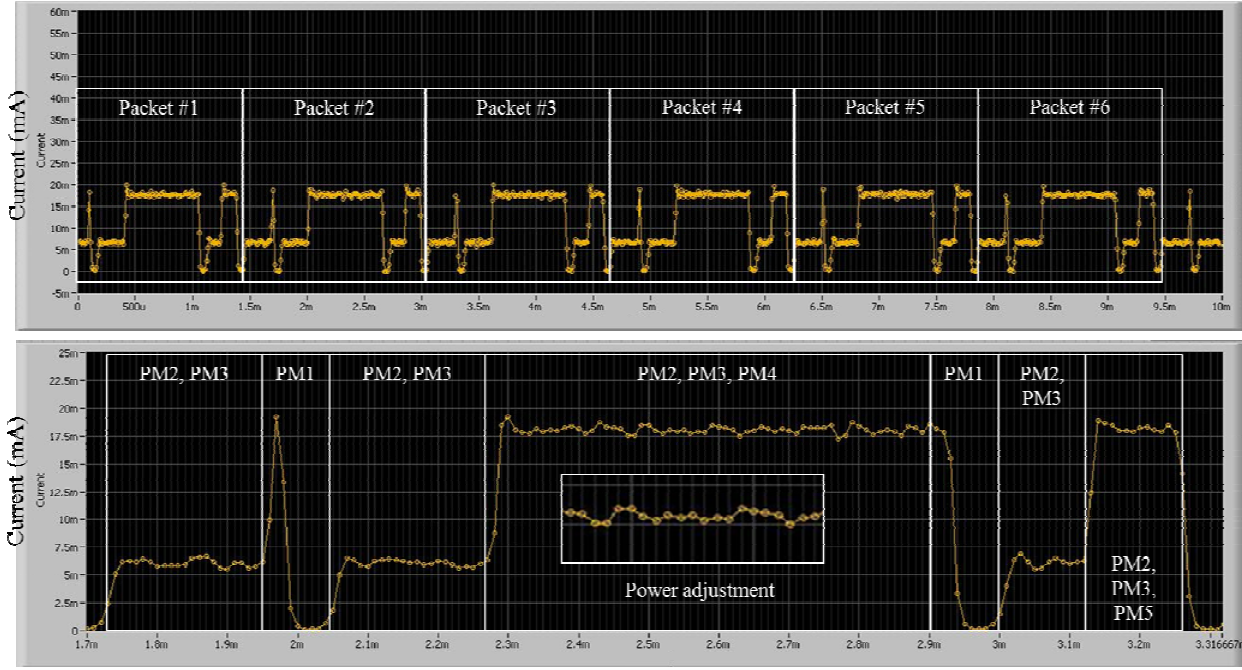
Figure 11. Amounts of power consumed by on-time power-aware scheduler during transmission of